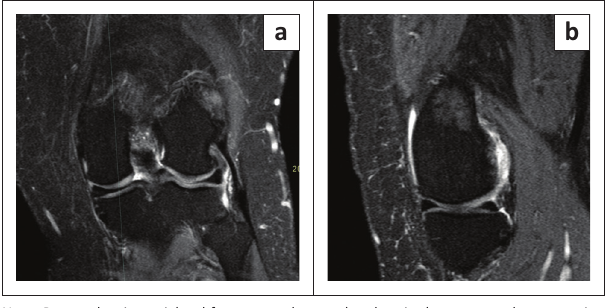
Note: Proton density weighted fat saturated coronal and sagittal sequences demonstrating high signal (white arrow) in the hypointense posterior horn of the medial meniscus (MM) in where MRI had no retrospective findings to support an MM tear. FIGURE 7: False negative medial meniscus tear: (a) coronal view and (b) sagittal view.